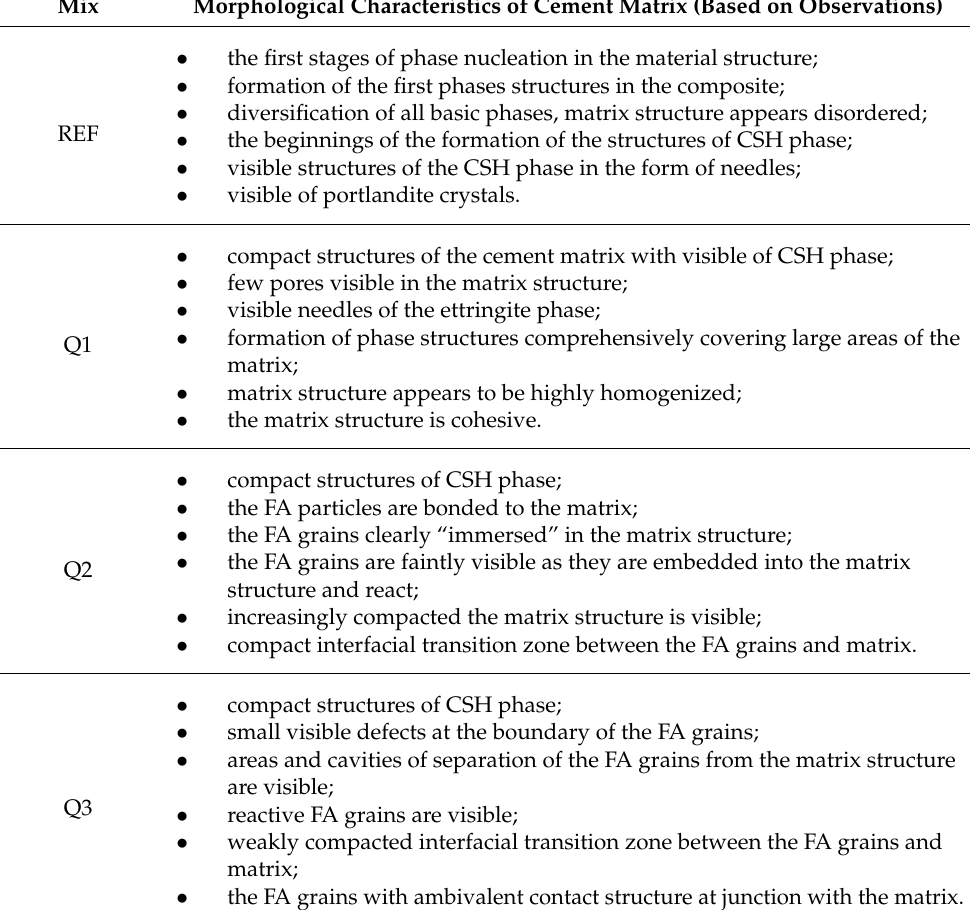
Table 8. Morphology of the matrix of analyzed quaternary concretes.